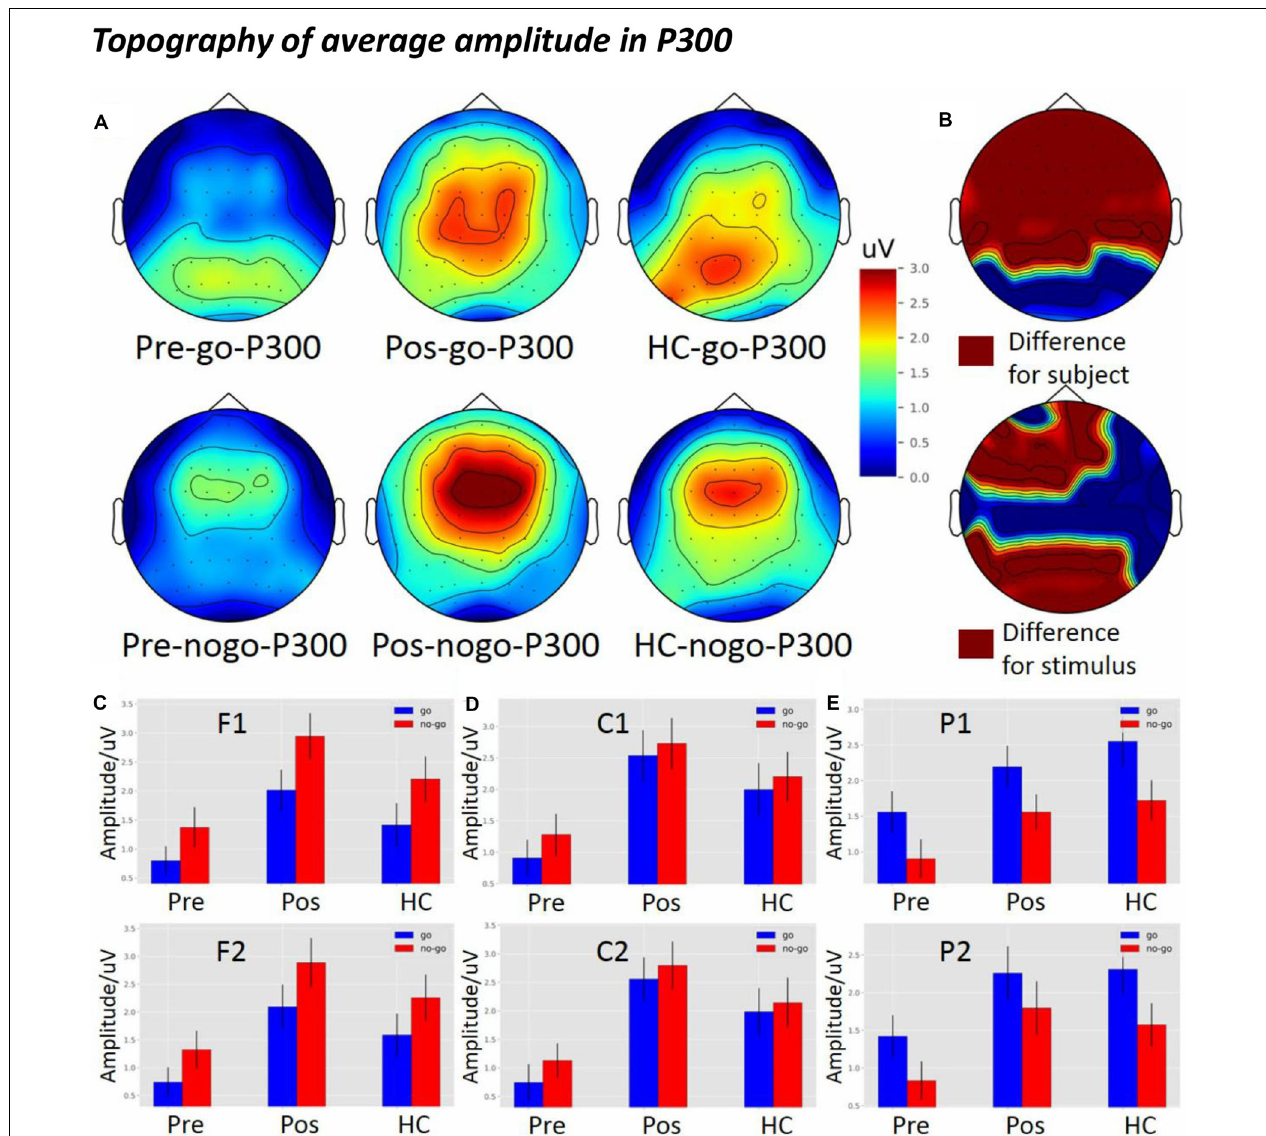
FIGURE 6 | The average amplitude topography of P300 and the average amplitude of P300 among the three groups in Go and Nogo conditions. (A) The left, middle, and right columns show the topography of the pre-operative group, post-operative group, and HCs. The top and bottom panel indicate the topography of the Go and the Nogo trials, respectively. (B) The top panel shows the significant difference in topography among the subject groups, and the bottom panel shows the significant difference in topography among the different stimuli ( p < 0.05) from two-way analysis of variance (ANOVA). (C) The P300 average amplitude among the three groups under different types of stimuli at the F1 and F2 electrodes. (D) The P300 average amplitude among the three groups under different types of stimuli at the C1 and C2 electrodes. (E) The P300 average amplitude among the three groups under different types of stimuli at the P1 and P2 electrodes. pre, pre-operative group; post, post-operative group; HC, healthy control